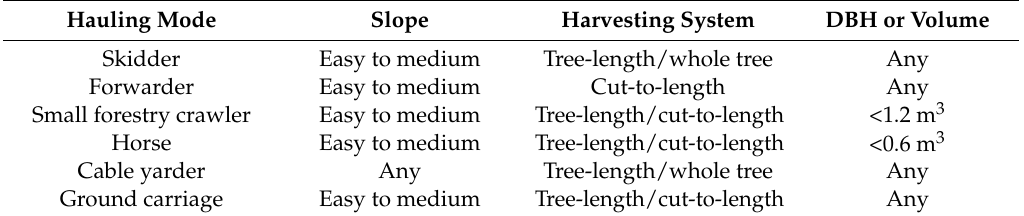
Table 4. Applied extraction systems with regard to terrain slope, log length and diameter at breast height (DBH). Hauling Mode Slope